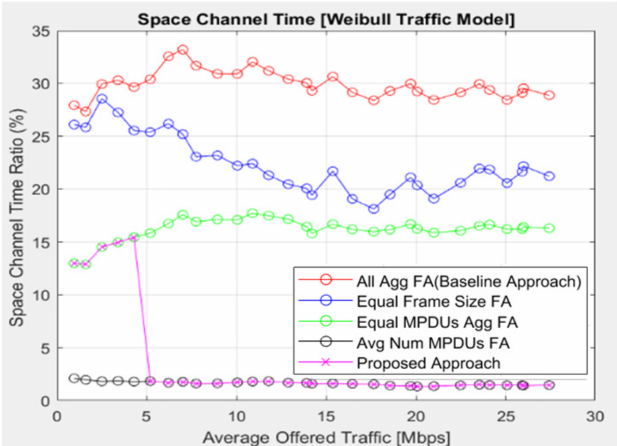
Figure 10. Performance of space channel time ratio with increasing offered traffic load using the Pareto traffic model.